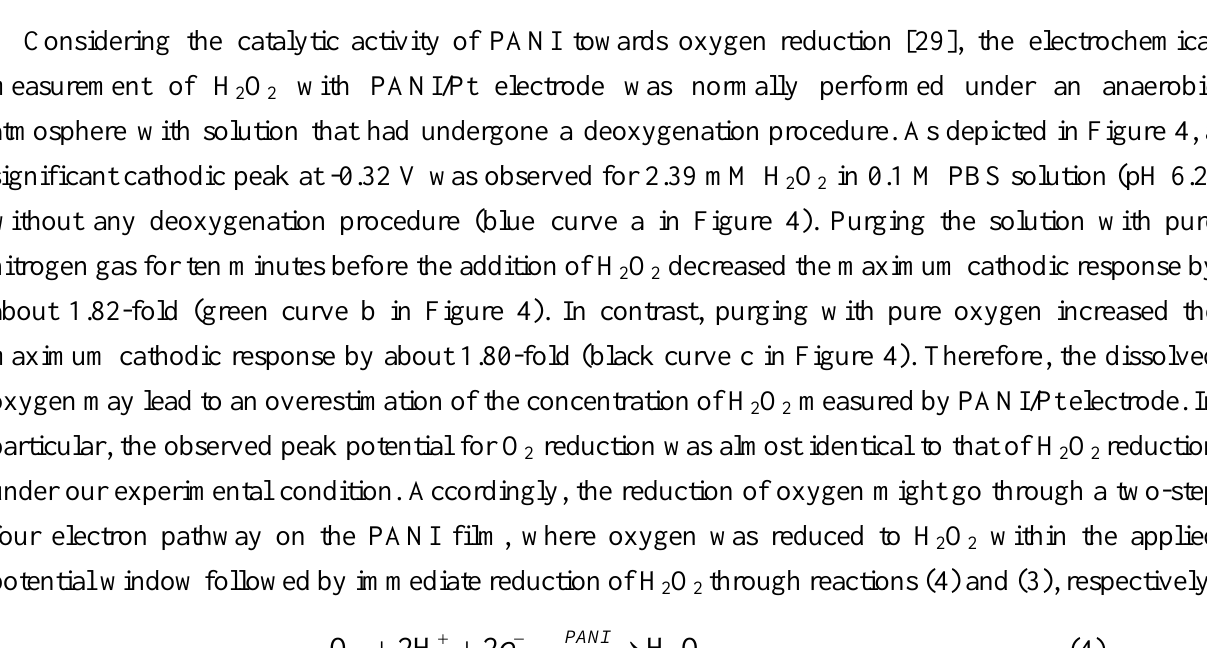
Figure 4. Cyclic voltammograms of PANI/Pt electrode in 0.1 M phosphate buffer (pH 6.2) containing 2.39 mM H O , where (a) had no further pretreatment (blue), (b) was purged 2 2 with N for 10 minutes (green), and (c) was purged with pure O 2 There was no H O added for (d) 2 2